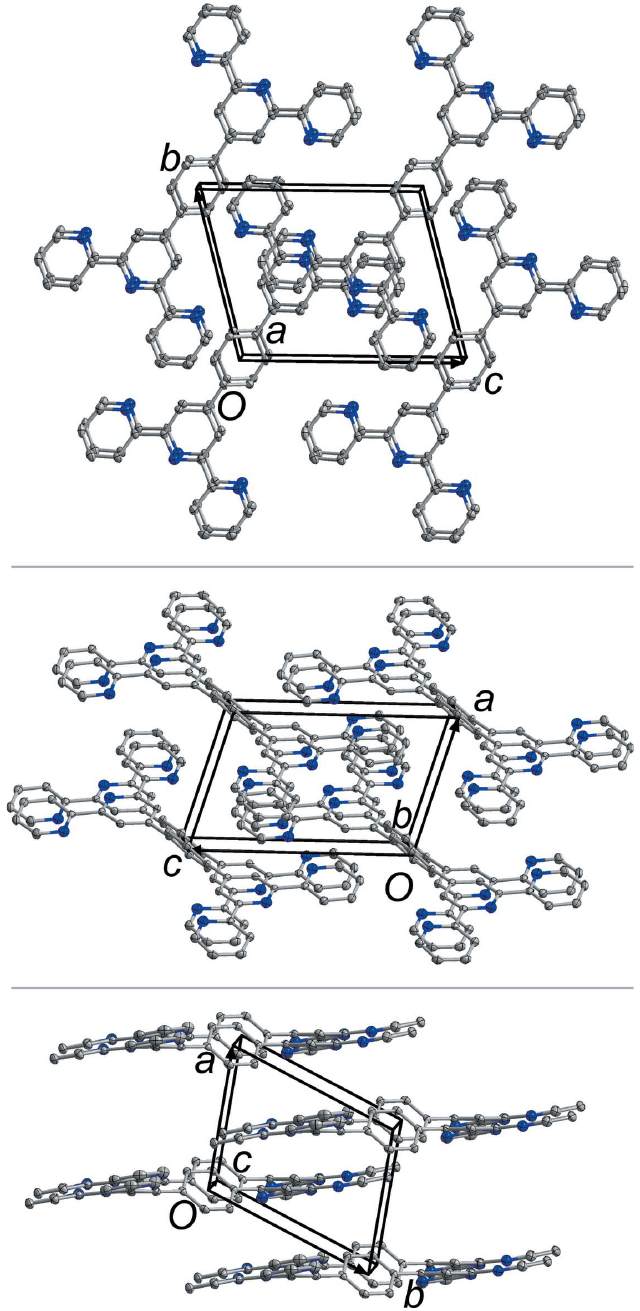
Figure 3 The crystal packing of the title triclinic polymorph (Form I) viewed along the a (top), b (middle) and c (bottom) axes.